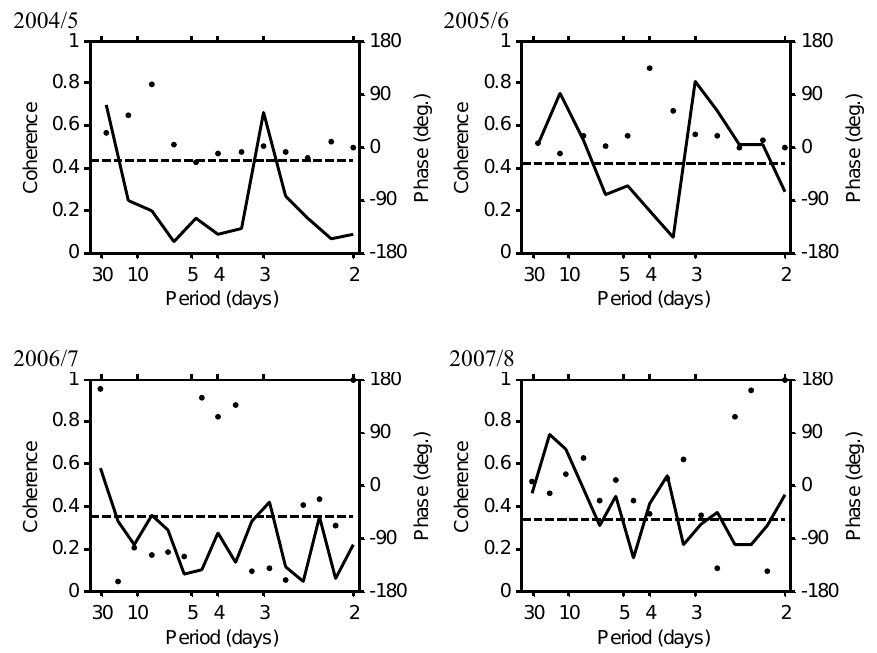
Fig. 13. Coherence (solid line, scale on left axis) and phase (dots, scale on right axis) between the detrended sequences of zonal mean Fig. 13 temperatures at the Antarctic mesopause (80–85 ◦ S, 0.002hPa) and in the Arctic winter stratosphere ( > 65 ◦ N, 21–4.6hPa) for the four winter intervals used in Fig. 12. The dashed line indicates a 95% confidence level. Time lags are applied based upon the results from Fig. 12. See text for